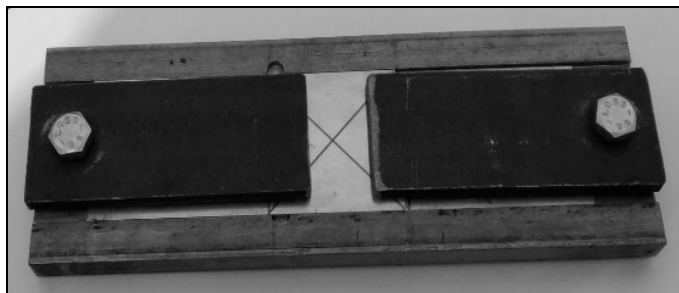
Figure 4. The welding fixture.